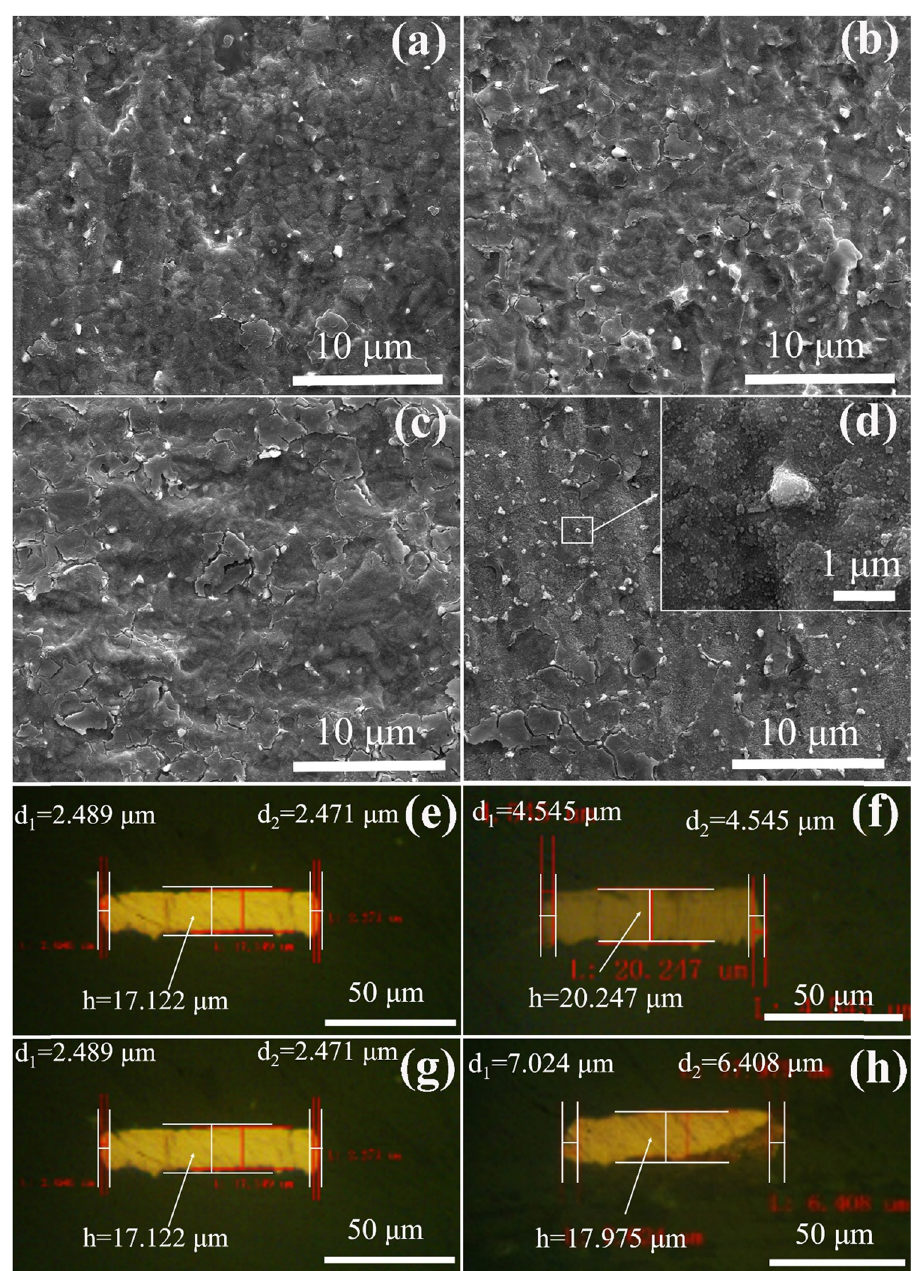
Figure 11: ( a – d ) SEM results of treated tin coating for samples 1 – 4 and ( e – h ) the side corrosion morphology of copper circuits from a cross - sectional